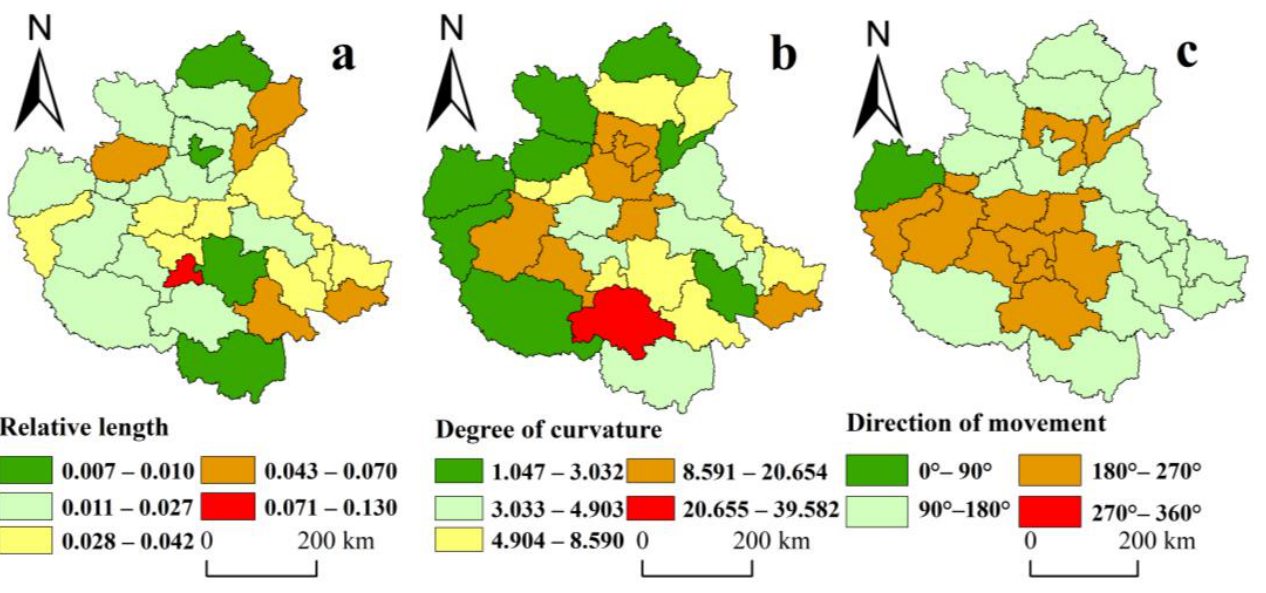
Figure 6. Schematic diagram of LISA time path analysis results. ( a ) Relative length of LISA time path; ( b ) LISA time path curvature; ( c ) LISA time path moving direction.